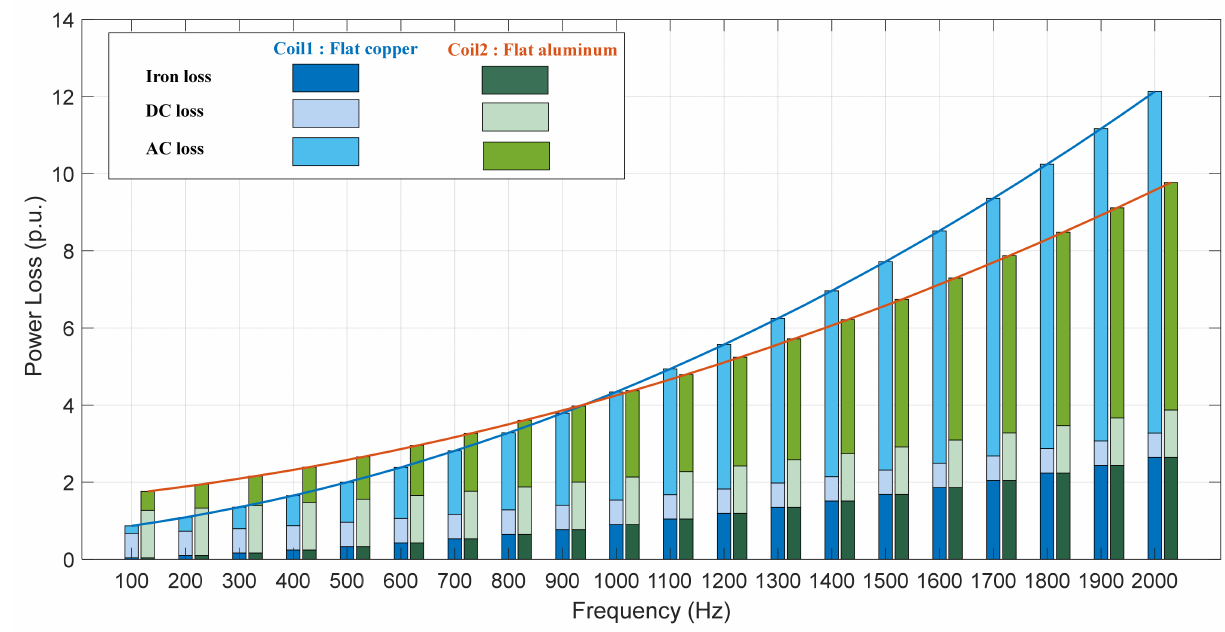
Figure 12. Total measured loss and its components at different frequency levels at 25 ◦